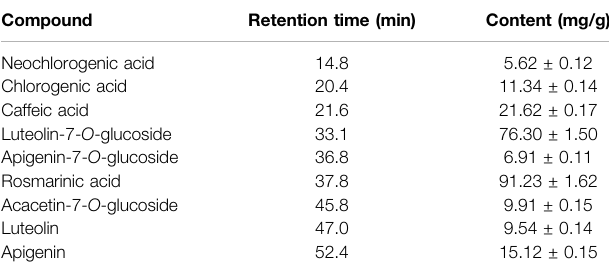
TABLE 2 | Contents of polyphenols in the MFDE evaluated by HPLC analysis. Compound Retention time (min) Content (mg/g) Neochlorogenic